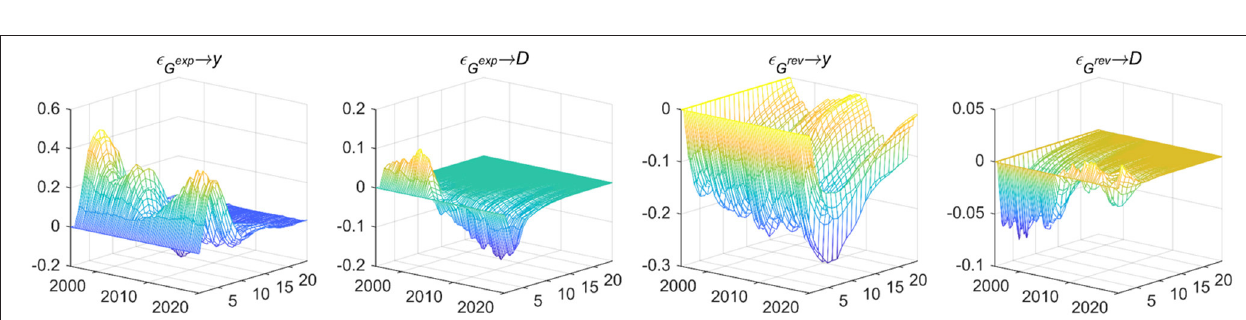
Frontiers in Public Health |